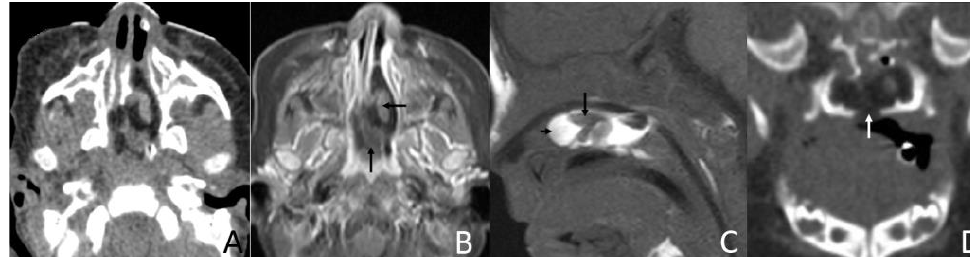
Figure 1. CT and MRI of a 2-month and 17-day girl presenting shortly after birth with dyspnea and inspiratory stridor. ( A ) Axial CT, displayed in the soft-tissue window, shows the soft palate mass protruding to the left nasal cavity and blocking the bilateral choanae to be of predominantly low attenuation, containing an irregular moderate-attenuation stalk. ( B ) Axial, postcontrast, T1W-SPIR MRI shows that the lesion’s stalk is slightly enhanced (arrows), but the rest of the lesion is not enhanced. ( C ) Sagittal T1-weighted MRI shows an irregular mass in the soft palate and left nasal cavity that mainly has a high-signal (short arrow) with an irregular low-signal central stalk (long arrow). ( D ) Coronal CT, displayed in the bone window, shows the soft palate mass associated with the cleft palate (arrow).